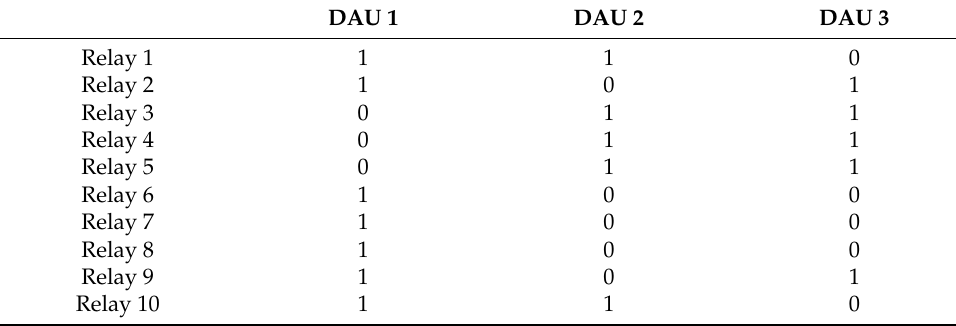
Table 1. DAU decision results under Scheme